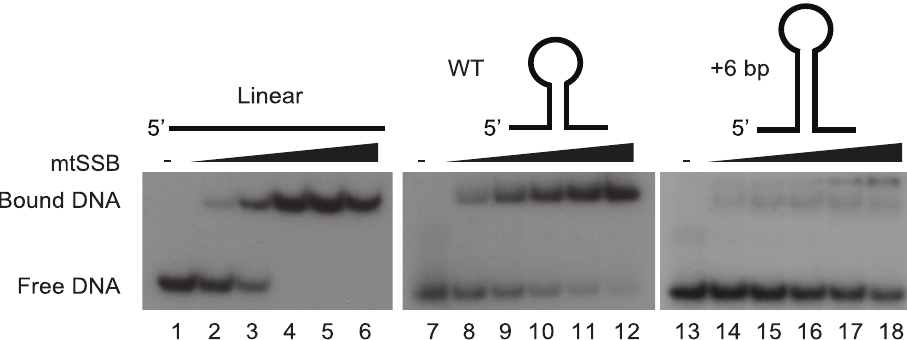
Figure 3. The stem-loop structure of OriL prevents mtSSB binding. MtSSB binding to ssDNA oligonucleotides was monitored by EMSA as described in experimental procedures. Increasing mtSSB concentrations (0, 5,10, 25, 50 100 fmol mtSSB calculated as a tetramer) were incubated for 15 minutes at room temperature with 25 fmol of [ c - 32P]-ATP 5 9 -end labeled DNA. As templates we used WT OriL, an OriL derivative lacking a stem or an OriL derivative with a 6 bp increase in stem